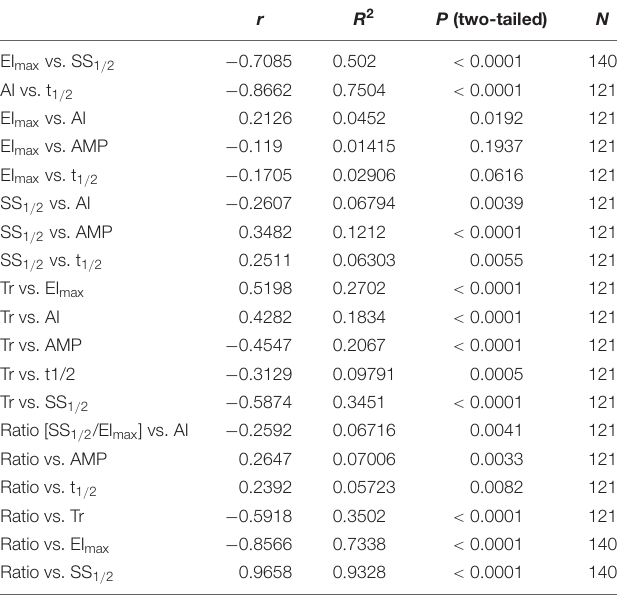
TABLE 1 | Determination of the correlation between deformability and